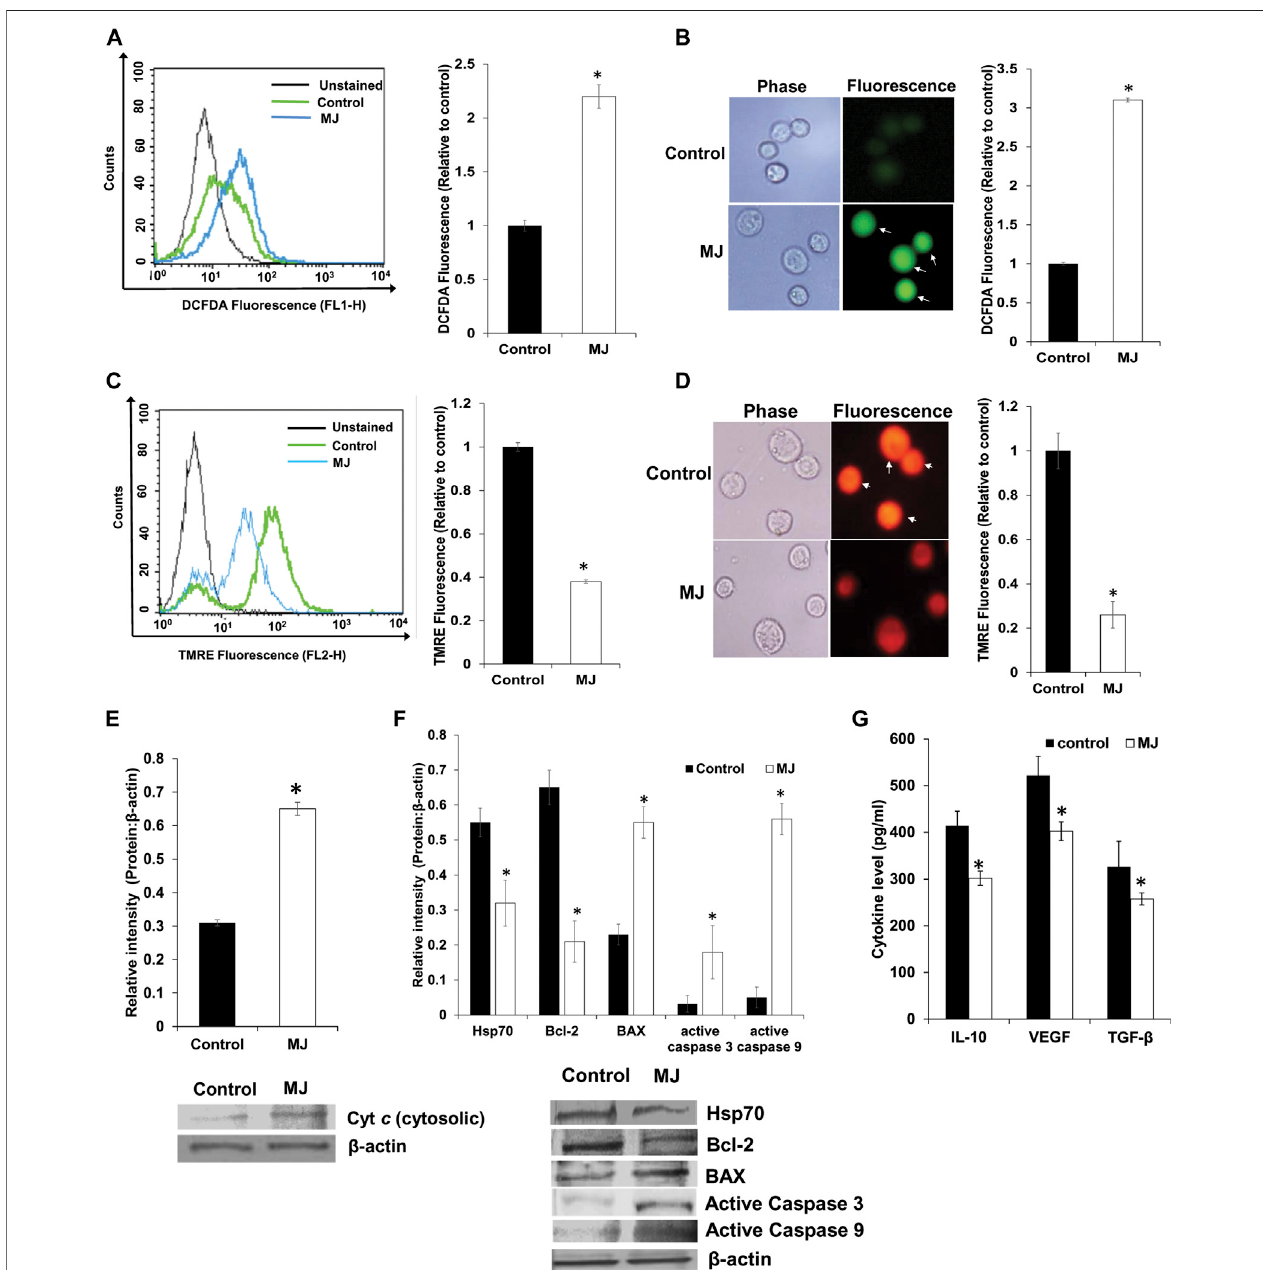
FIGURE 3 | Effect of MJ on the expression of ROS, mitochondrial membrane potential and expression of cytosolic Cyt c and cell survival regulatory molecules. Tumor cells (1 × 10 5 cells/ml) were incubated in medium alone or containing MJ (2.5 mM) for 2 h, followed by estimation of ROS expression by fl ow cytometry (A) and fl uorescence microscopy (B) . The mitochondrial membrane potential was estimated following 4 h of MJ (2.5 mM) treatment by fl ow cytometry (C) and fl uorescence microscopy (D) .Thecytosolicfraction ofthecontroland MJ(2.5 mM)treatedtumor cells (1 × 10 5 cells/ml)following18 hofincubation intherespectivetreatments were analyzed for the Cyt c by Western blotting (E) . The fl ow cytometric (A,C) , fl uorescence microscopic (B,D) , and Western blotting (E) images are from a representative experiment out ofthree independentexperiments withasimilar pattern. Arrowsindicate cellspositiveforDCFDA (B) and TMREstaining (D) , respectively. Accompanying bar diagrams (A – E) are mean ± SD of quantitative values of the fl ow cytometric analysis and densitometry of fl uorescence, and Western blots, respectively. * p < 0.05 vs. respective control. Tumor cells (1 × 10 5 cells/ml) of control and MJ-treated (2.5 mM) groups were also analyzed for the expression of the indicatedcellsurvivalregulatoryproteinsbyWesternblottingasdescribedinthematerialsandmethods (F) .Bands (F) shownarefromarepresentativeexperimentoutof three independent experiments witha similar pattern.The accompanying bar diagrams are the densitometry analysisof thebands (F) . Tumor cells (1 × 10 5 cell/ml) were incubated in medium alone or containing MJ (2.5 mM) for 18 h followed by estimation of the indicated cytokines in the culture supernatant by ELISA (G) as described in thematerialsandmethods.Valuesshownarebardiagramsaremean ± SDofthreeindependentexperiments.* p < 0.05vs.respectivecontrol.Valuesshownaremean ± SD * p < 0.05 vs. respective